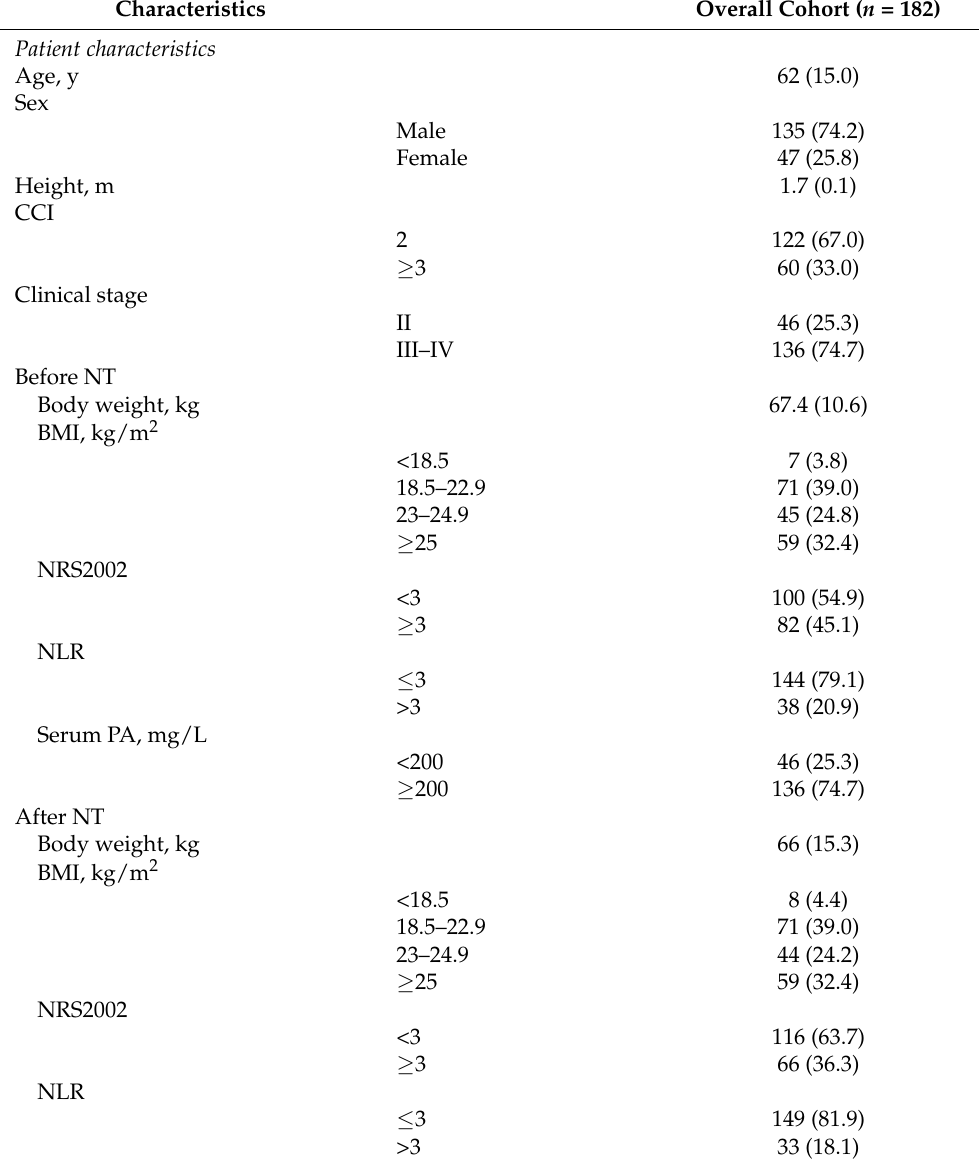
Table 1. Patient characteristics, neoadjuvant treatments, operative details, and tumor